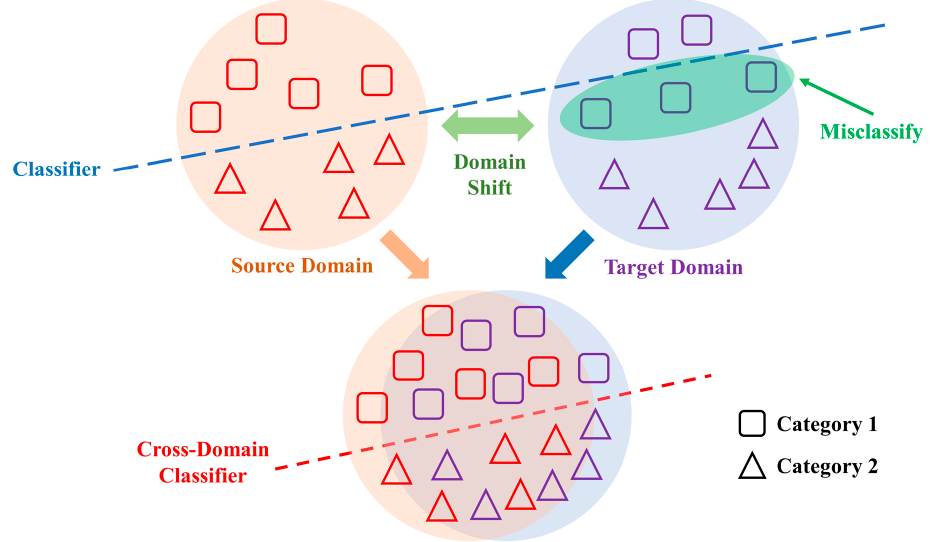
Figure 1. Description of domain shift and domain adaptation.